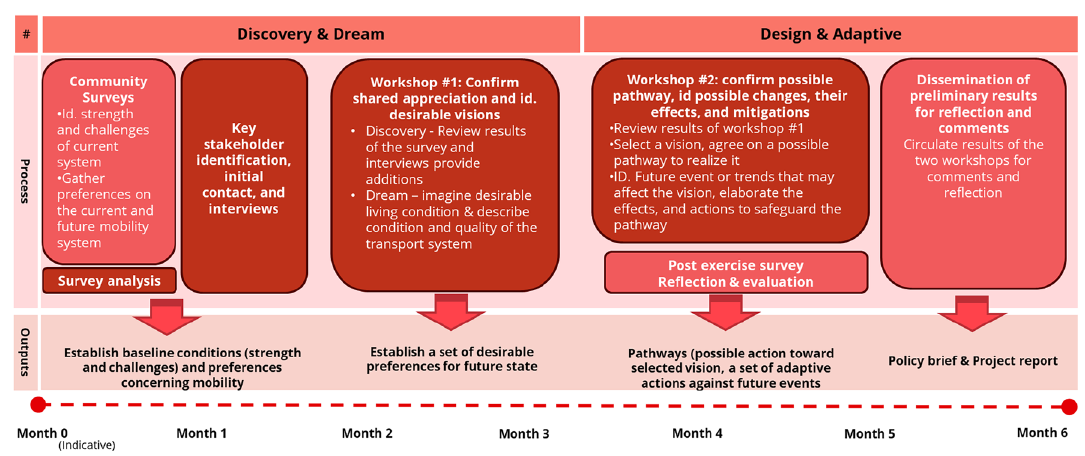
Figure 3. Process to implement a robust and generative visioning framework for the case